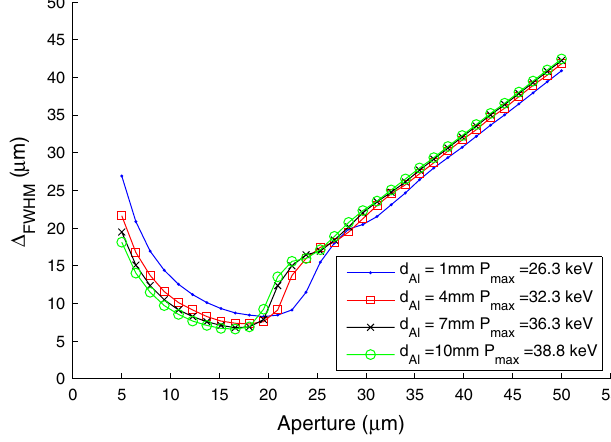
FIG. 12. (Color) FWHM of the PSF of pinhole 2 as a function of the slit apertures and for several thickness of Al filter.